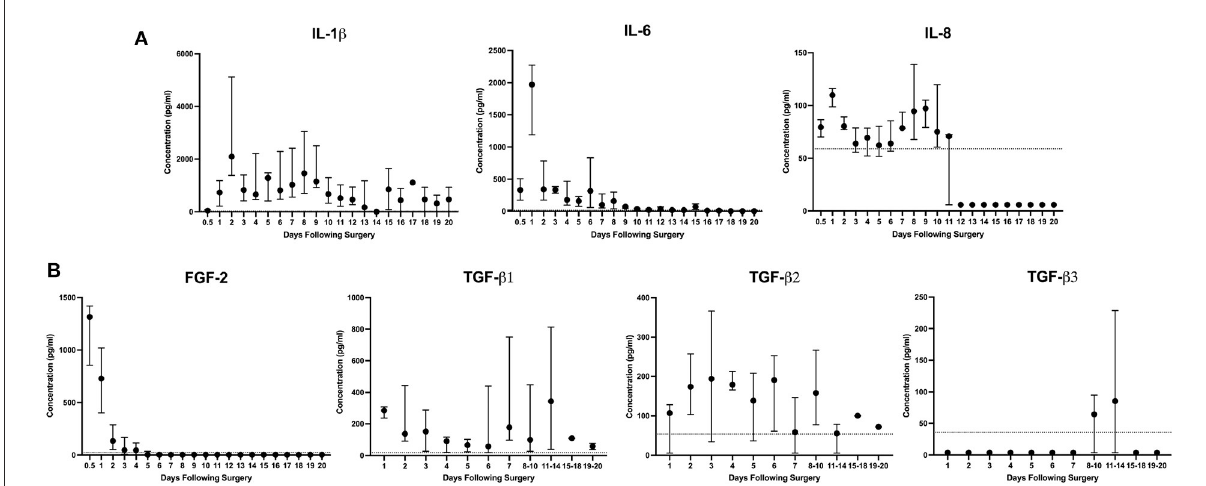
FIGURE2 IL-1 β and IL-6 are the predominant inflammatory cytokines present following surgically induced equine SDFT injury. Descriptive report of (A) inflammatory cytokines and (B) growth factors FGF-2 and TGF- β 1, − 2, and − 3 in tendon ultrafiltrate were measured by ELISA following bilateral surgically induced SDFT injury of the forelimb over 21 days in 6 horses. Due to insufficient volume, samples from days 8 onward were grouped for TGF- β isoform analysis. When present, the dashed line at the y-axis represents the lower limit of quantification (LLoQ) for that cytokine or growth factor as determined by the assay manufacturer (MilliporeSigma, MA, USA). Concentrations measured below the LLoQ were assigned a value of 0.1 of the LLoQ.